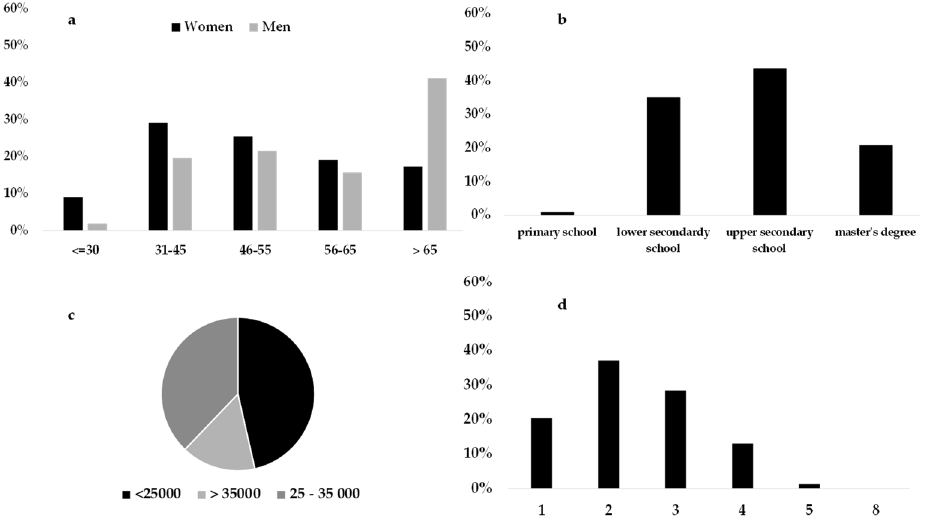
Figure 5. Sociodemographic characteristics of consumers belonging to value for money cluster: ( a ) Gender and age groups proportion, ( b ) educational level, ( c ) yearly average income bracket, and ( d ) number of family components.